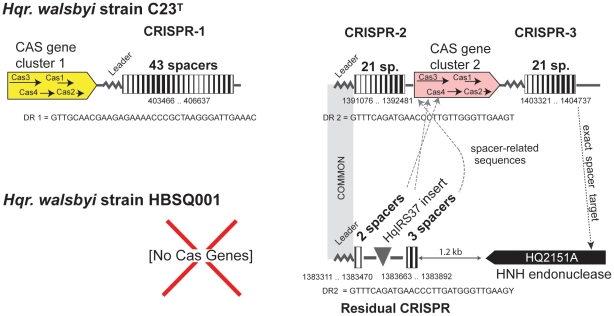
CRISPR systems of Hqr. walsbyi strains C23T and HBSQ001.Three CRISPR loci are present in C23T, associated with two separate groups of Cas genes (coloured yellow and pink). No Cas genes, and only one, residual CRISPR with 5 spacers, are found in HBSQ001. The DR (direct repeat) sequences are shown beneath the CRISPRs. Shading between the leader sequence of CRISPR-2 of C23T and CRISPR-1 of HBSQ001 indicate that they are nearly identical in sequence. The relative position and orientation of ORF HB2151A is shown along with an arrow indicating where it matches (exactly) a spacer sequence in CRISPR-3 of C23T. Similarly, the spacer sequences in HBSQ001 that are closely similar to sequences in C23T are indicated by arrows, labeled spacer-related sequences, which point to their matching locations in the C23T genome. Nucleotide positions are given beneath the CRISPRs and details of the matching spacer sequences are given in Table S7.